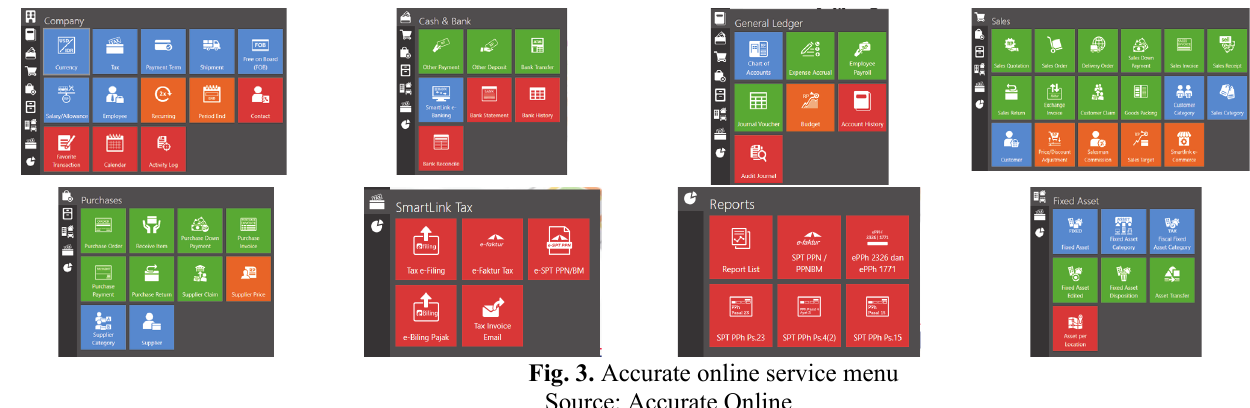
Fig. 3. Accurate online service menu Source: Accurate